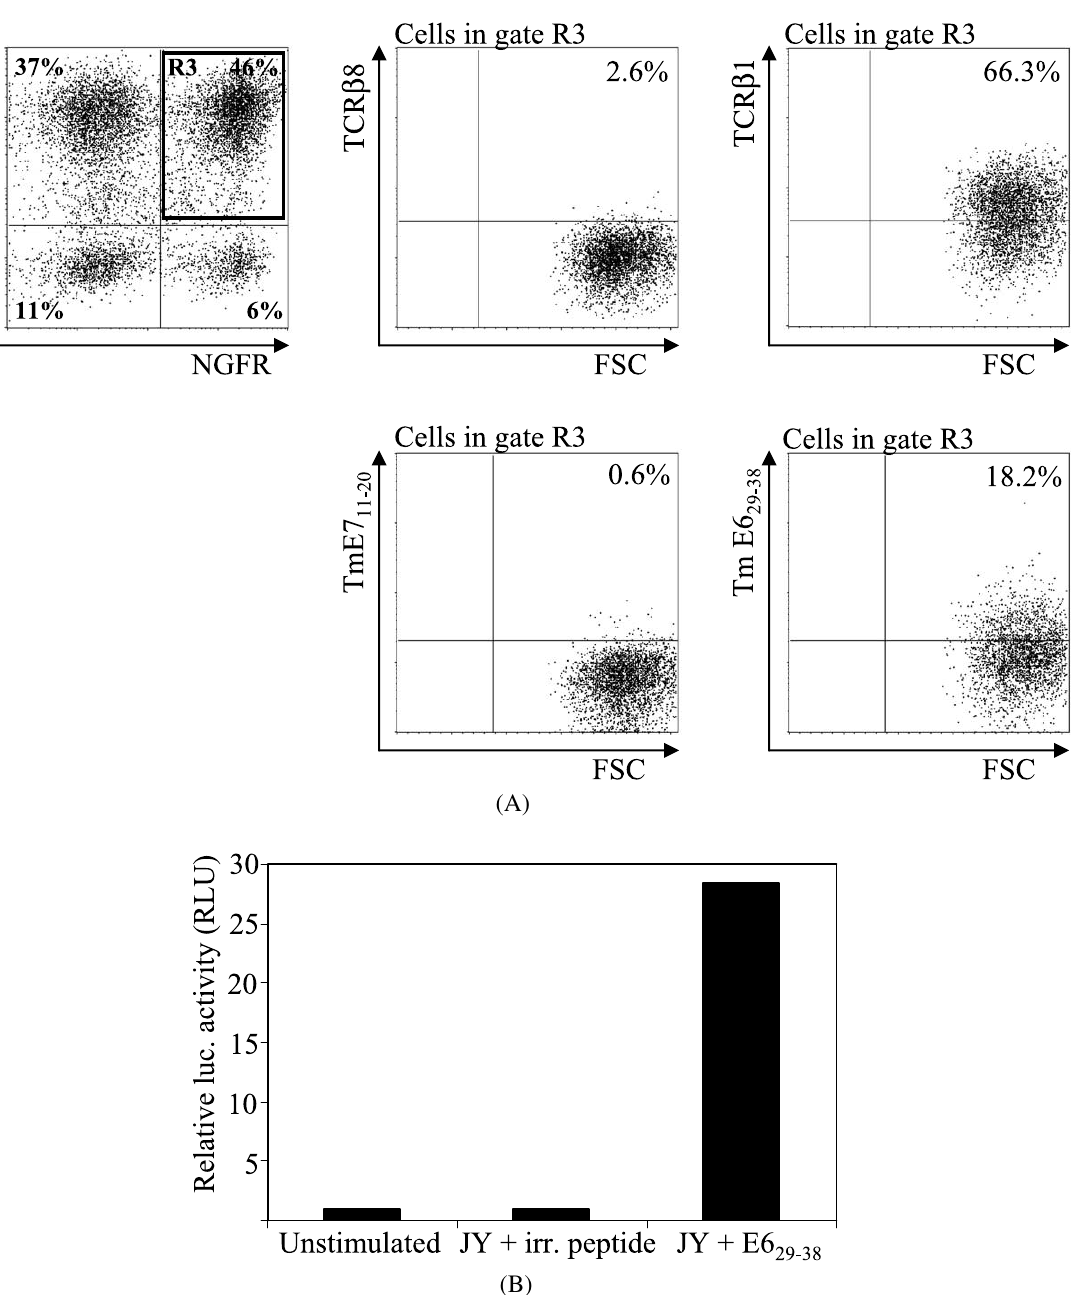
Fig. 1. Phenotypical and functional activity analysis of HPV16E6 specific TCR transgenic JurMA cells. (A) 7E7-TCR transgenic JurMA cells co-expressing GFP and NGFR (gated in R3) are negative for TCRV β 8 but positive for TCRV β 1 staining as indicated by the percentage of TCRV β positive cells (upper right quadrant). Tetramer analysis of 7E7-TCR transgenic JurMA cells co-expressing GFP and NGFR show binding to relevant but not irrelevant tetramer as indicated by the percentage tetramer positive cells (upper right quadrant). (B) Functional activity of 7E7-TCR transgenic JurMA cells against peptide loaded target cells as determined in a luciferase assay. Luciferase activity in JurMA cells is shown in Relative Luminescence Units (RLU), defined as the ratio of luciferase activity in stimulated versus unstimulated cells. Data presented are representative for 2 different experiments